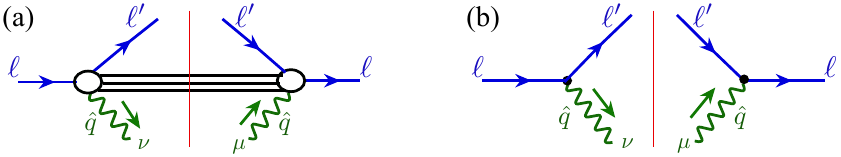
Figure 14 . Illustration of (a) the general leptonic tensor, e L µν ( ‘, ‘ 0 , ˆ q ) , and (b) the lowest-order contribution to e L µν ( ‘, ‘ 0 , ˆ q )